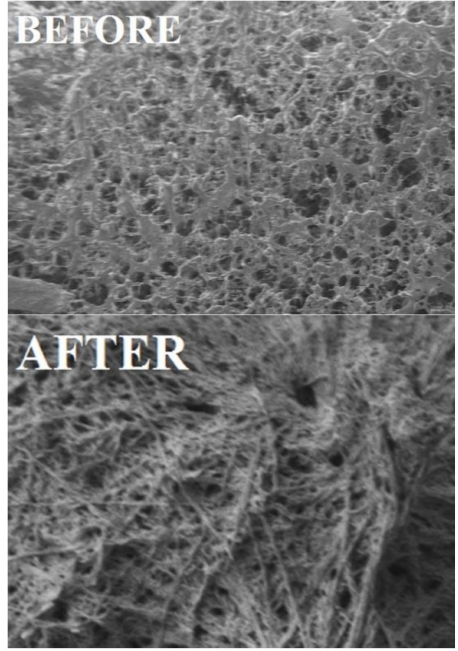
Figure 15. SEM images of copolymer IIIb (before grafting) and after grafted copolymer with tyrosine V at 500 ×